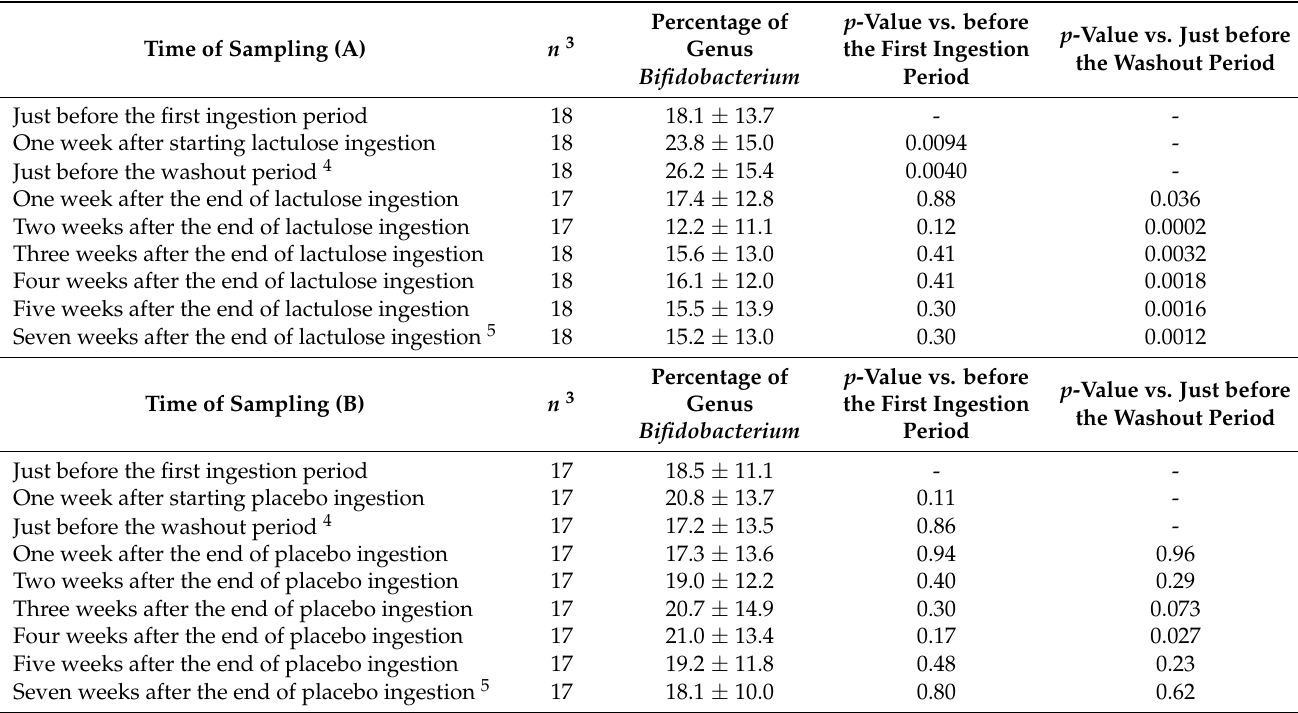
Table 4. ( A ) Transition in the percentages of genus Bifidobacterium in the faecal microbiomes of group A consuming lactulose 1,2 . ( B ) Transition in the percentages of genus Bifidobacterium in the faecal microbiomes of group B consuming placebo 1,2